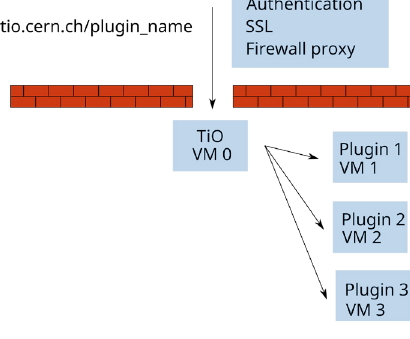
Figure 3. The diagram of the current Tile-in-One architecture. Figure 4. The diagram of the new Tile-in-One